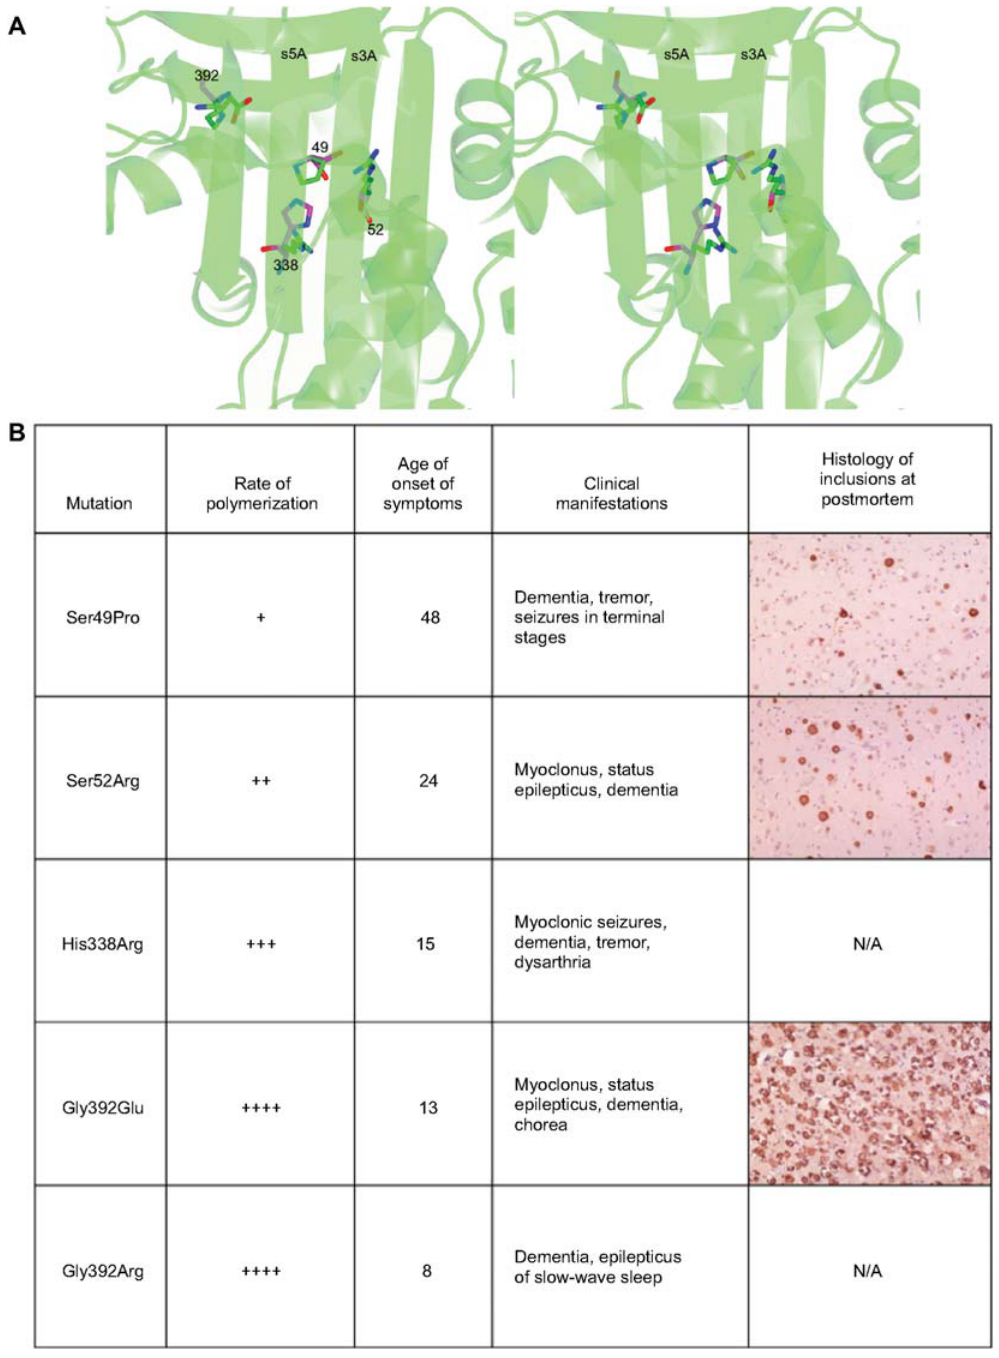
Figure 5 (A) Stereo view of the hNS shutter region (pdb code 3F5N). The wild-type residues in positions 49, 52, 338 and 392 are shown in magenta sticks; green sticks show the mutated residues responsible for FENIB. (B) Table showing for each of the five known hNS mutants the tendency for polymerization, the corresponding severity of symptoms and the accumulation of Collins bodies in histological samples. Adapted, with permission, from ANNUAL REVIEWS Inc., Annu Rev Biochem (2009; 78: 147–76). adopts a conformation characterized by a left-handed a -helix the five molecules to be organized in a star-like arrangement (97). where the RCL establishes most of the intermolecular inter- All the above observations on the two native hNS crystal actions in the pentameric assembly. By contrast, in the C- structures underline once more the extreme flexibility of the terminally truncated hNS structure two identical molecules serpin RCLs. However, additional structural elements show are present in the asymmetric unit (r.m.s.d. of 0.1 A˚ /374 C a evident flexibility. The loop between s1B and s2B pairs). In this case, a stretch of six residues of the RCL